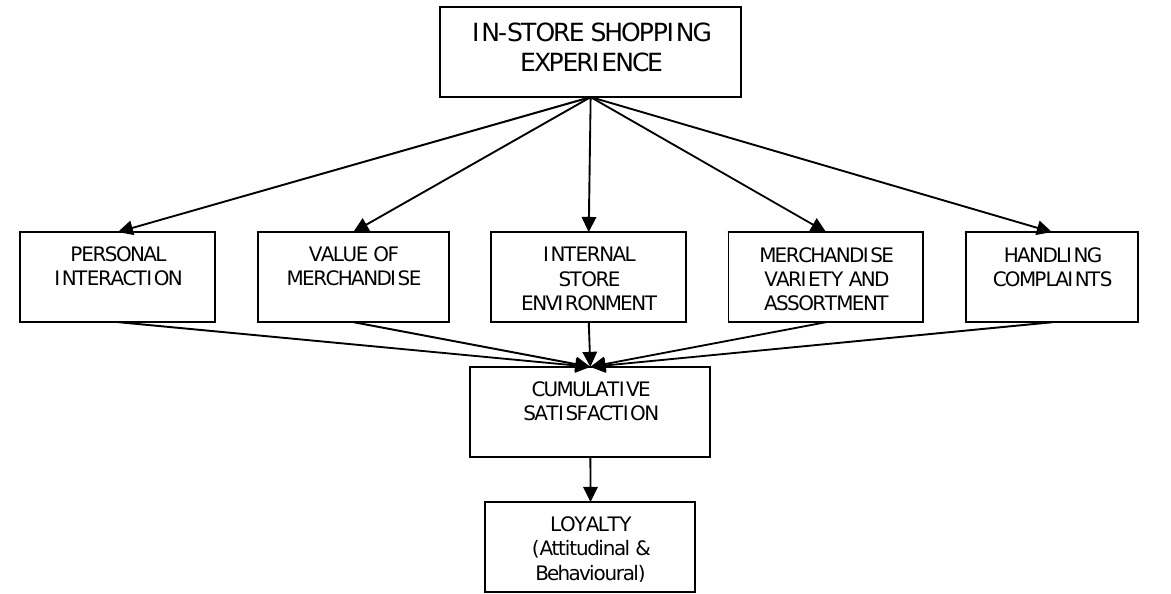
Figure 1: The dimensions and outcomes of the in-store shopping experience Based on the work of both Dabholkar et al. (1996) and Vásquez et a l. (2001), a measuring instrument that avoids the limitations of the aforementioned two measures and attempts to measure the perceptions of consumers’ in-store shopping experiences has been developed. The instrument is based on empirical data collected from more than 11 000 respondents from 31 stores and was subjected to a thorough scale development process that has been adequately reported elsewhere (Terblanche & Boshoff, 2002). The conclusion reached was that consumers’ in-store shopping experiences could be described as a five-dimensional construct, as seen in Figure